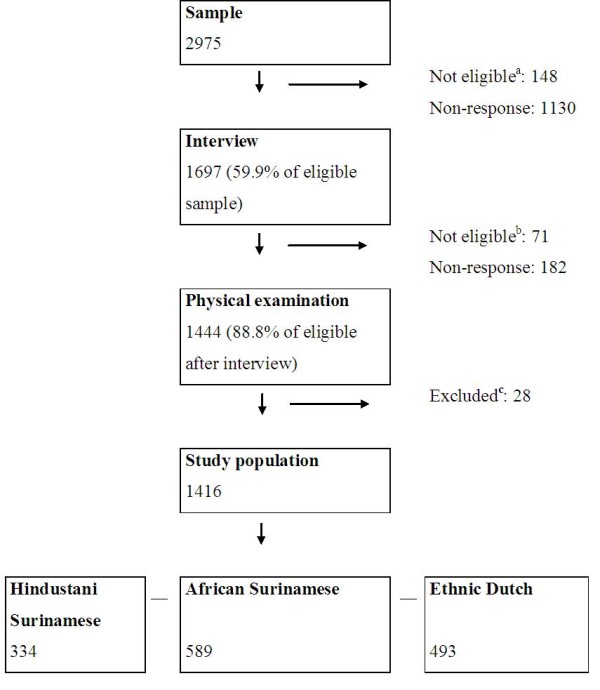
Flow chart of the inclusion into the study. a Persons who had moved, were deceased or could not be reached at the registered address were not considered as potential participants; b Only persons of Hindustani Surinamese, African Surinamese and Ethnic Dutch origin were invited for the physical examination (n = 1626). Surinamese participants in the interview who originated from Java or China (i.e. ‘other’ ethnicity) and persons with missing ethnicity were excluded (n = 71); c Persons without a measured waist circumference, height, urine albumin and creatinine measurement were excluded (n = 28). The inclusion in SUNSET was reported previously
[21].